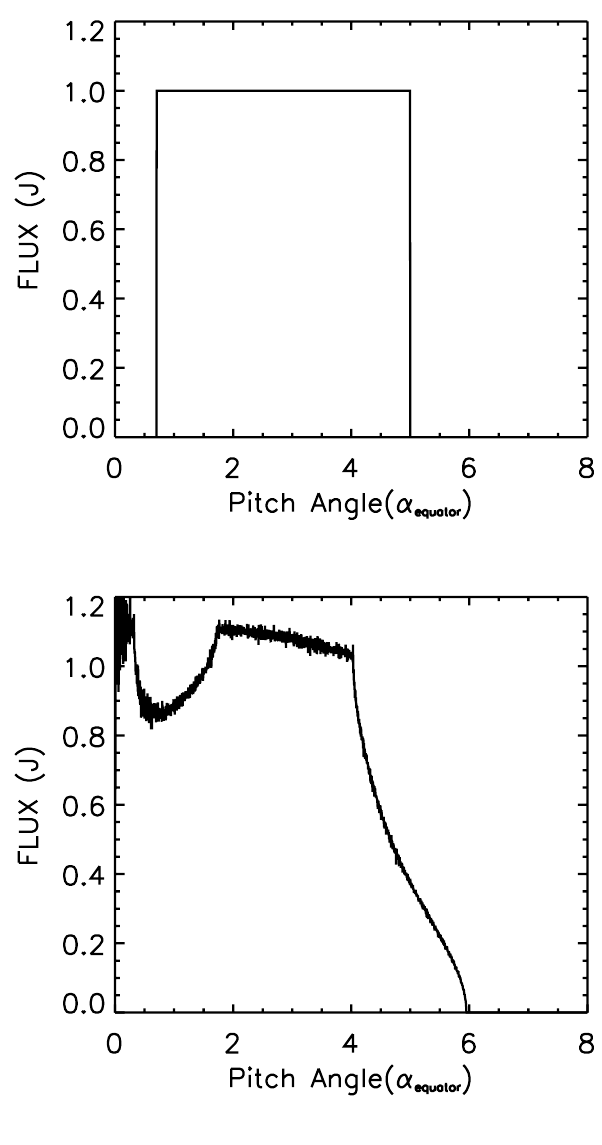
Fig. 5. Loss cone filling by pitch angle scattering. Initial pitch an- gle distribution (top), changed pitch angle distribution after passing through field reversal